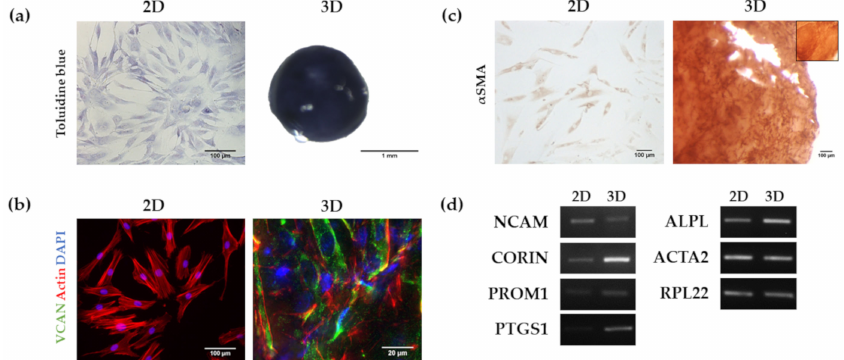
Figure 6. Analysis of HFDPC markers in 2D and RAD16-I 3D cultures. ( a ) Toluidine blue staining for the detection of glycosaminoglycans; ( b ) Versican (VCAN) immunofluorescence. VCAN was absent in 2D cultures but its expression was recovered in 3D cultures as shown by immunofluorescence detection; ( c ) α Smooth Muscle Actin ( α SMA) immunocytochemistry. α SMA was detected in both 2D and 3D cultures. The inner box represents a negative control (incubation with secondary antibody only); ( d ) Agarose gel of Reverse-transcription PCR products including Neural Cell Adhesion Molecule ( NCAM ), Corin ( CORIN ), Prominin-1 ( PROM1 ), Prostaglandin endoperoxidase synthase 1 ( PTGS1 ), alkaline phosphatase ( ALPL ) and α -Smooth Muscle Actin ( ACTA2